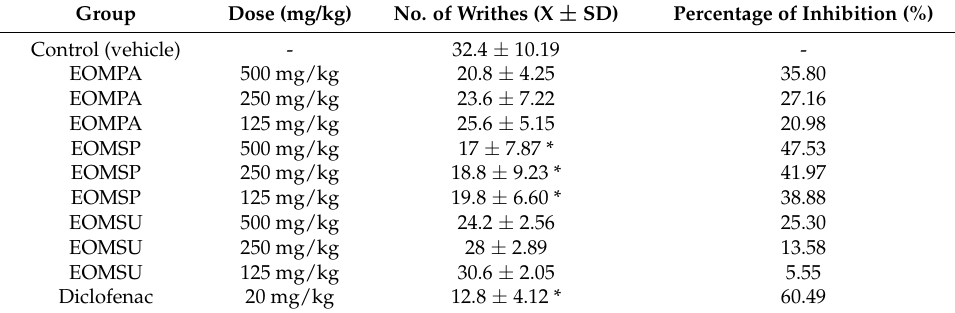
Table 3. Effect of the essential oils from the selected Mentha species in the acetic acid induced writhing test in